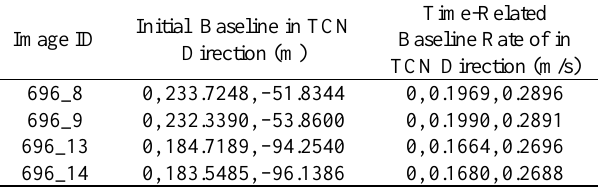
Table 1. Parameters of experimental images